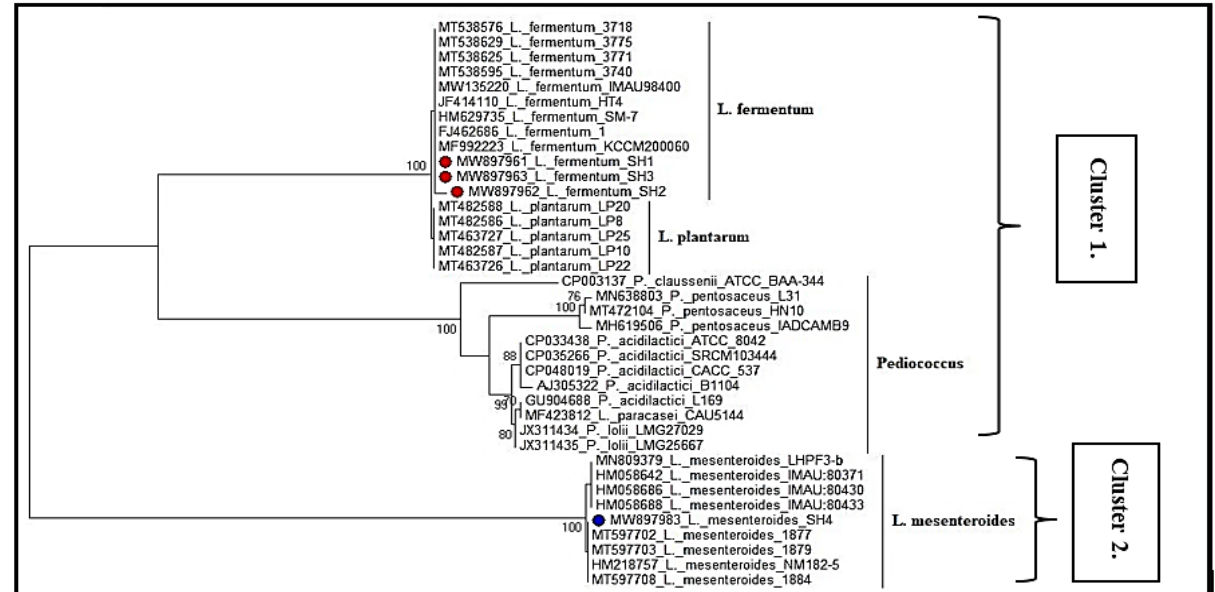
Figure 3. Unrooted phylogenetic tree of 16S rDNA gene sequences of the genera Limosilactobacillus and Leuconostoc isolate from boza and cider (1: boza A3 (MW897961_ L._fermentum _SH1); 2: Fermented cider, fridge B6 (MW897962_ L._fermentum _SH2); 3: Fermented cider, ambient C9 (MW897963_ L._ fermentum _SH3); 4: Unfermented cider D6 (MW897983_ L._mesenteroides _SH4)). All selected isolates were labeled with a circle ( ● for SH1, SH2, SH3; ● for SH4).